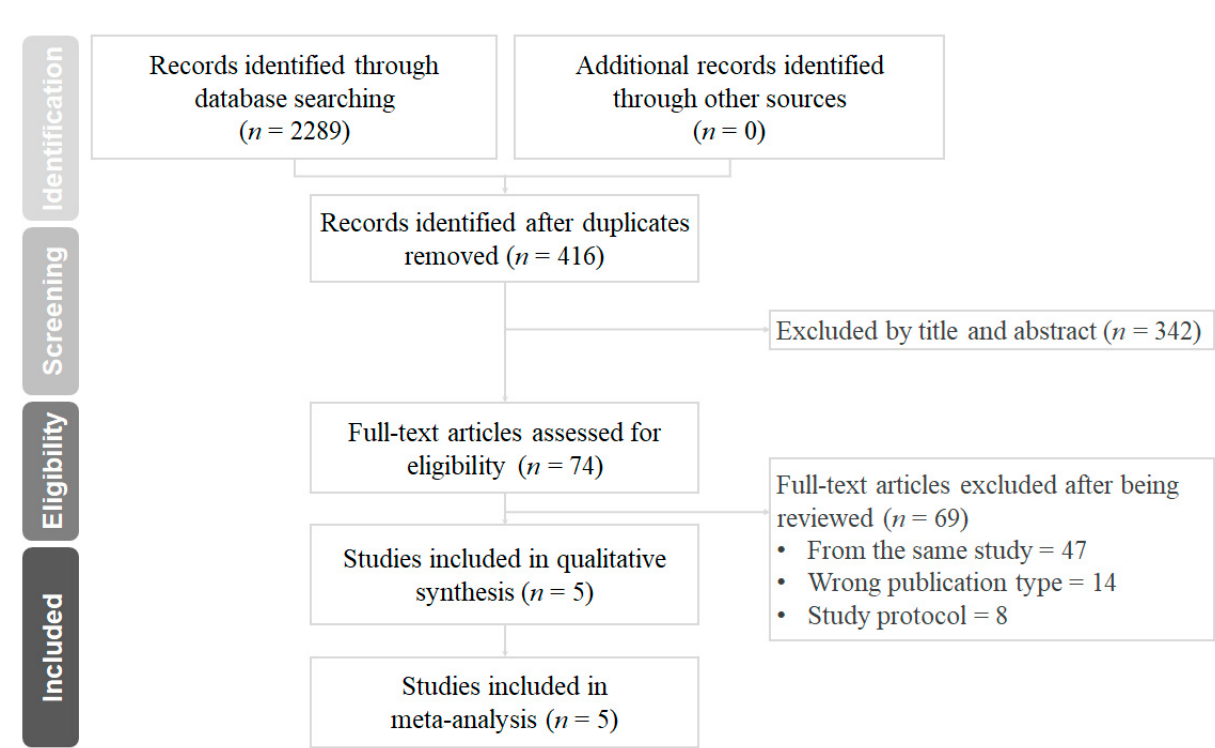
Figure 1. Preferred reporting items for systematic reviews and meta-analyses (PRISMA) diagram for the searching and identification of included studies. Table 1. Clinical characteristics and outcomes of included randomized trials.